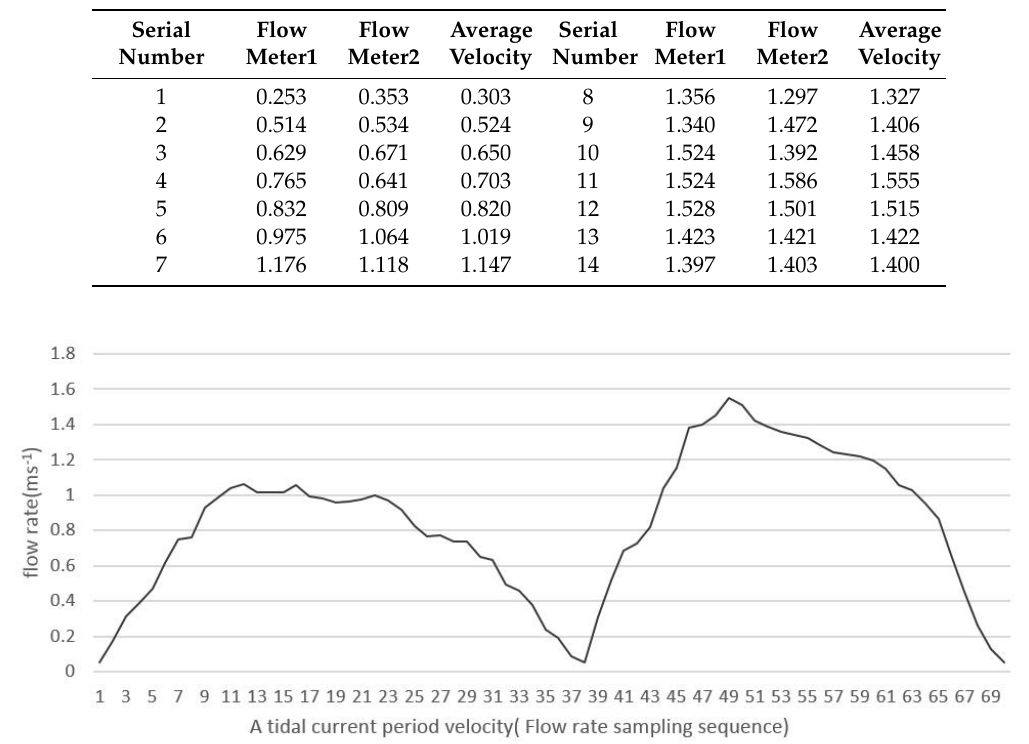
Table 4. Flow velocity data for a certain period of time.